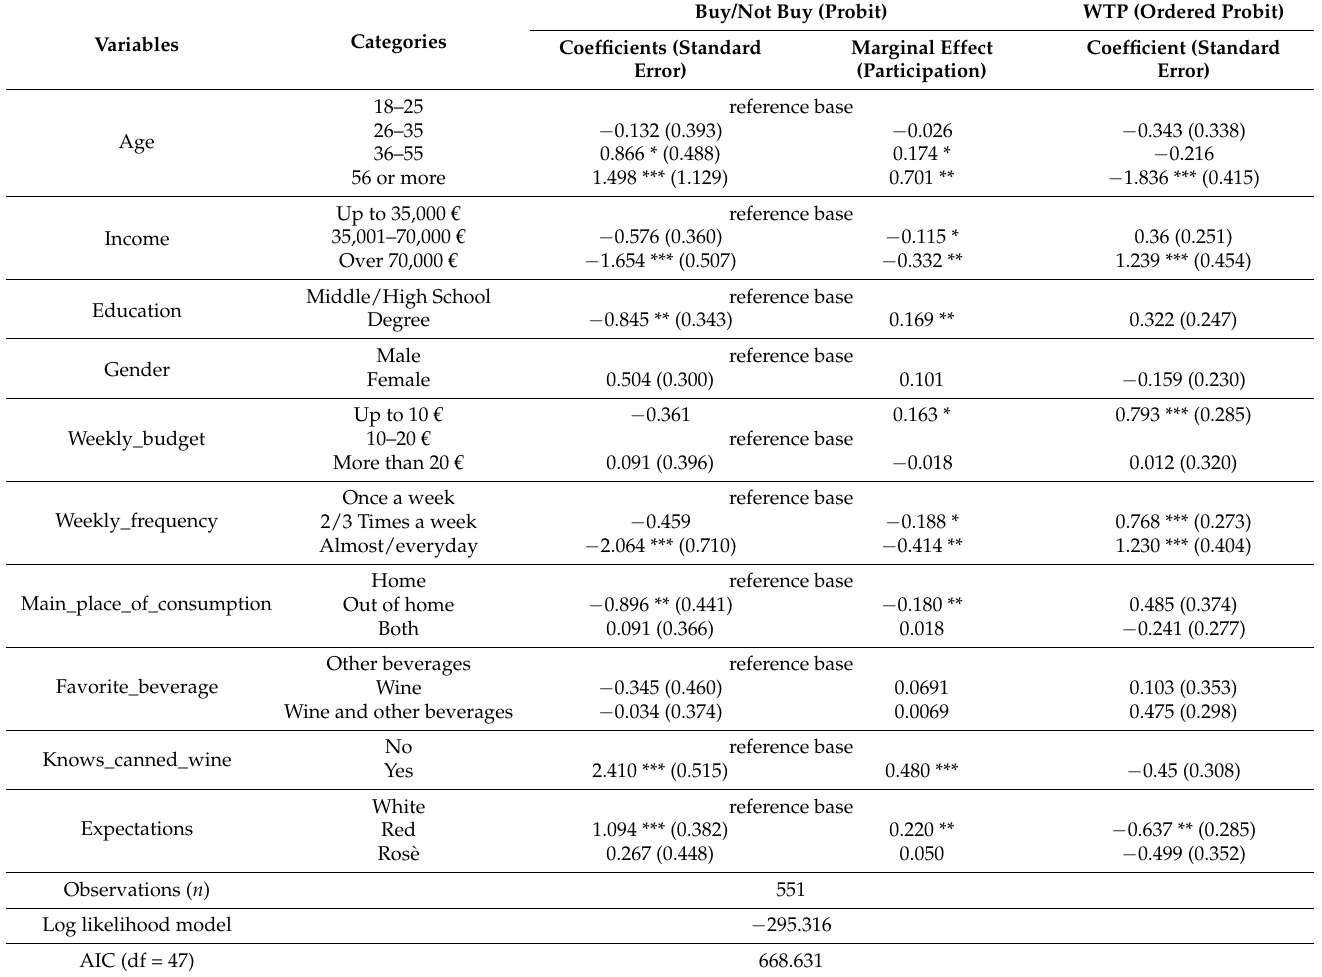
Table 3. Zero Inflated Ordered probit